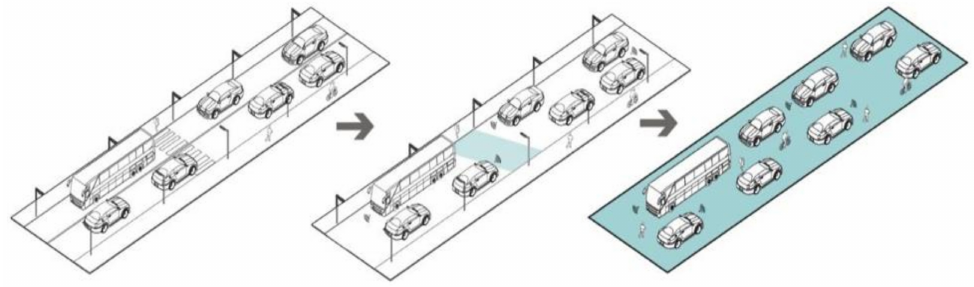
Figure 6. Supposed transformation regarding the road section after the diffusion of the CAVs [48].